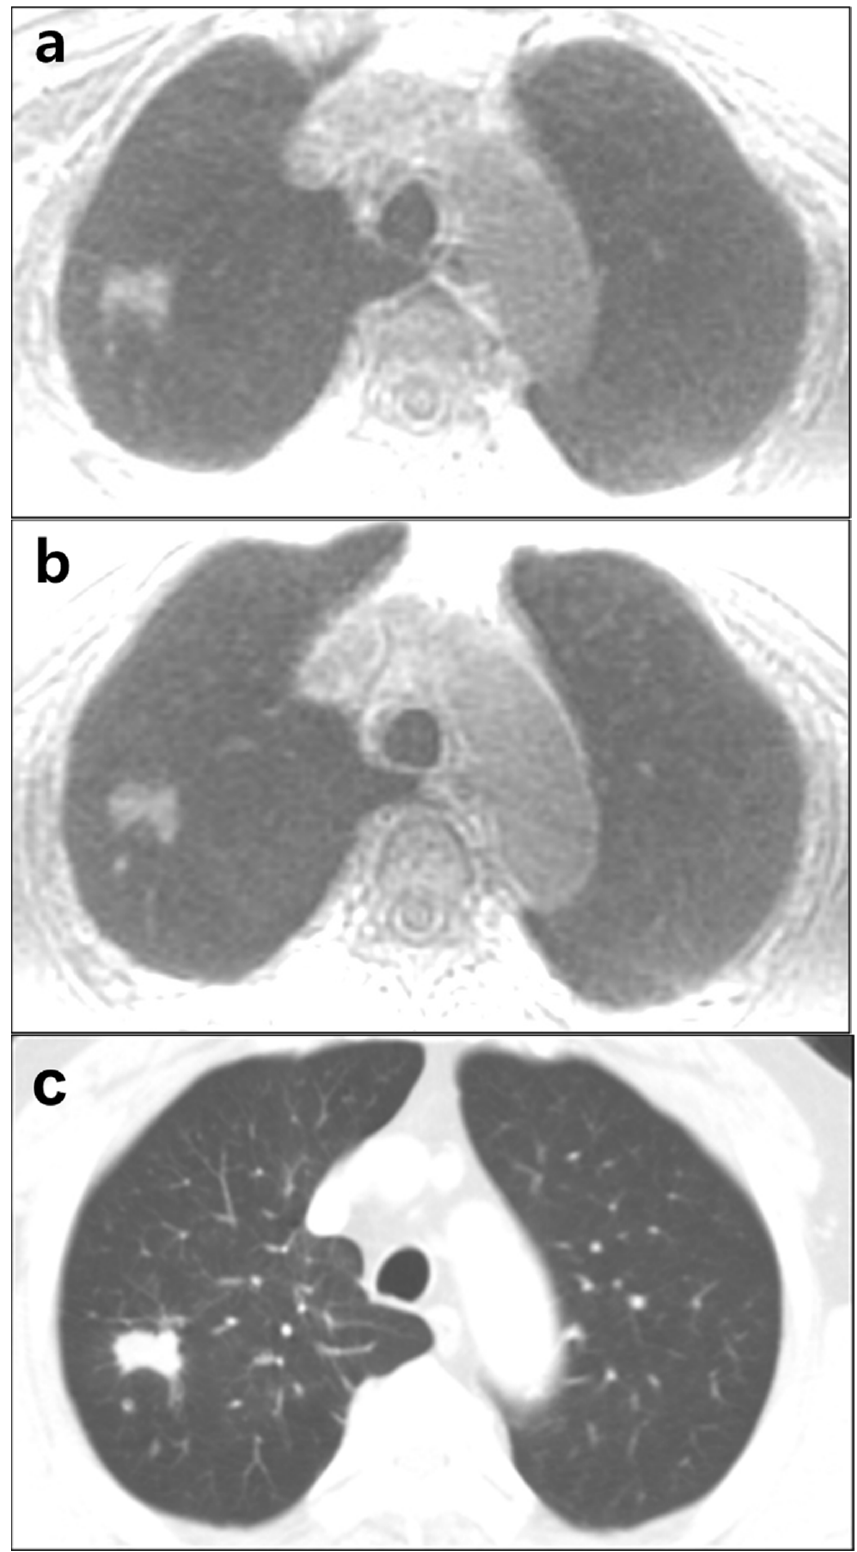
Figure 1. A 61-year-old male with lung cancer in the right upper lobe. A 24 mm-sized primary nodule and a tiny satellite nodule in the right upper lobe in ZTE-CAA ( a ) and ZTE-AIR ( b ) are shown. Chest CT image ( c ) is presented as reference. ZTE-CAA, zero echo time lung MR image using conventional anterior array coil; ZTE-AIR, zero echo time lung MR image using adaptive image receive coil.